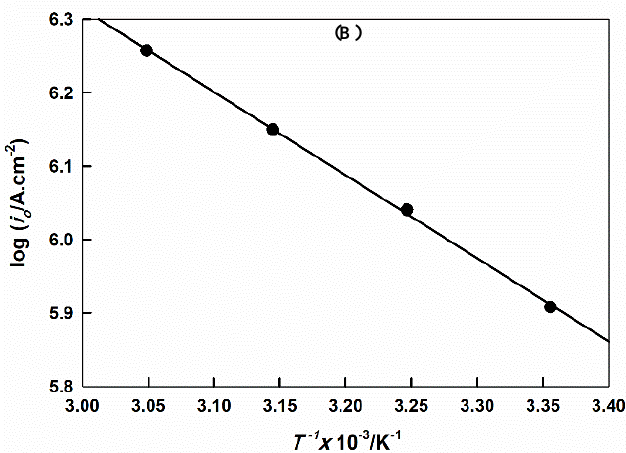
Figure 4. ( A ) The potentiodynamic polarization of GC/Sr 2 PdO 3 at different temperatures in 0.1 M HClO 4 solution, and ( B ) the corresponding Arrhenius plot.